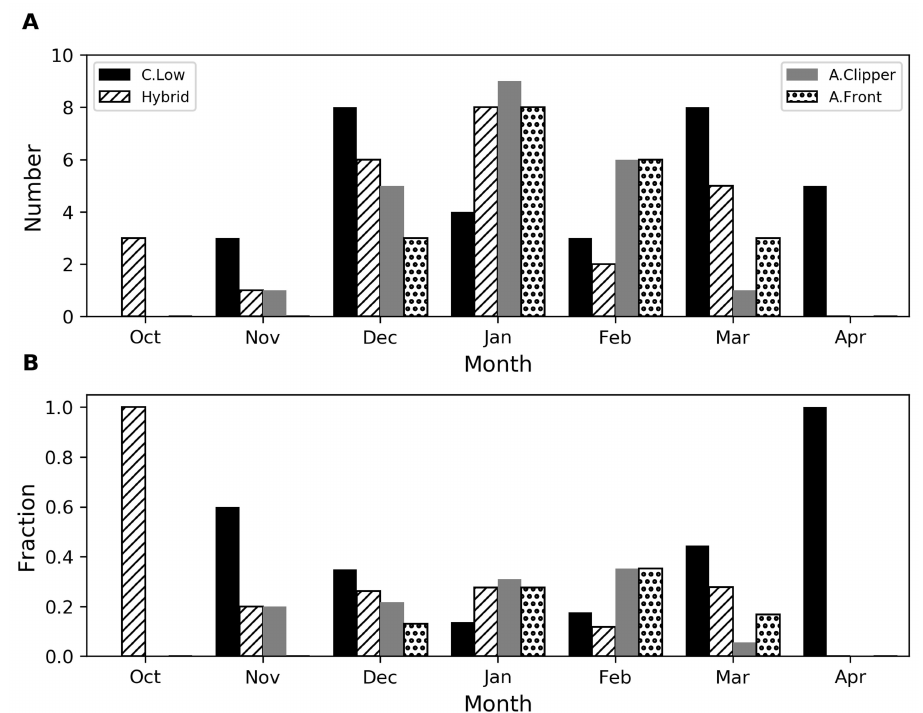
Figure 8. ( a ) Number and ( b ) fraction of monthly blizzards for the winter seasons of 1979–1980 and 2017–2018, separated by